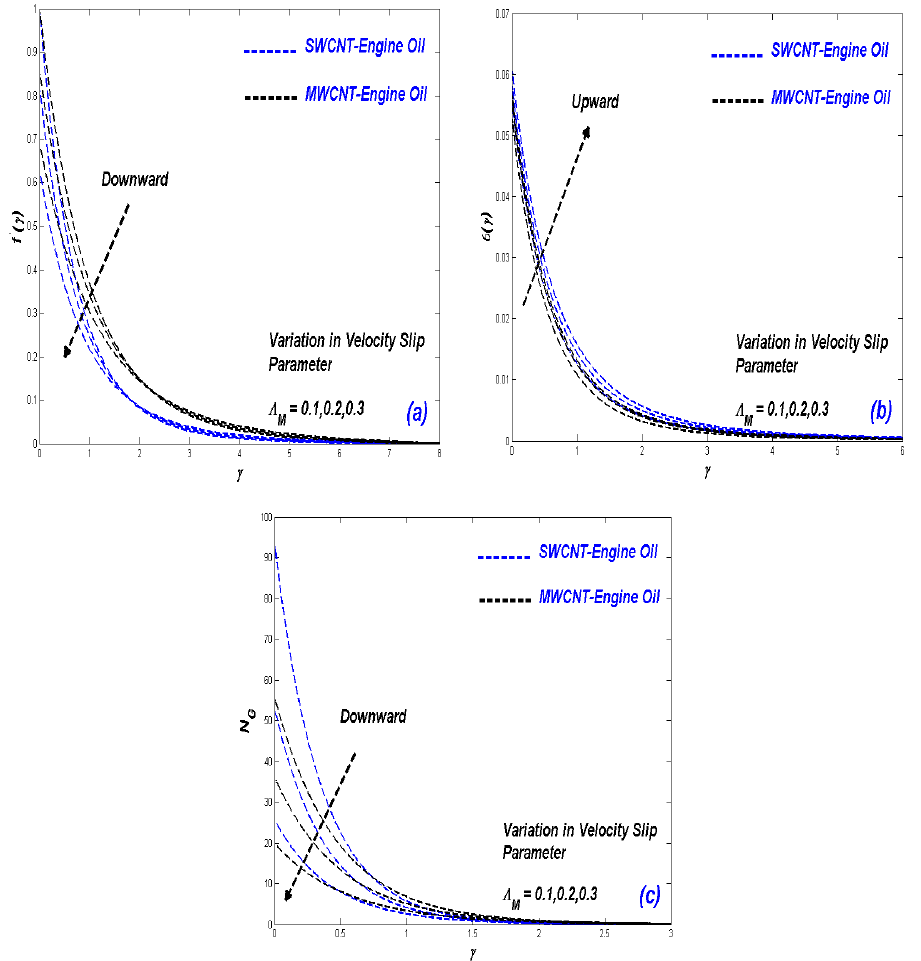
Figure 7. ( a ) Velocity change with Λ M ; ( b ) Temperature change with Λ M ; ( c ) Entropy change with Λ M .